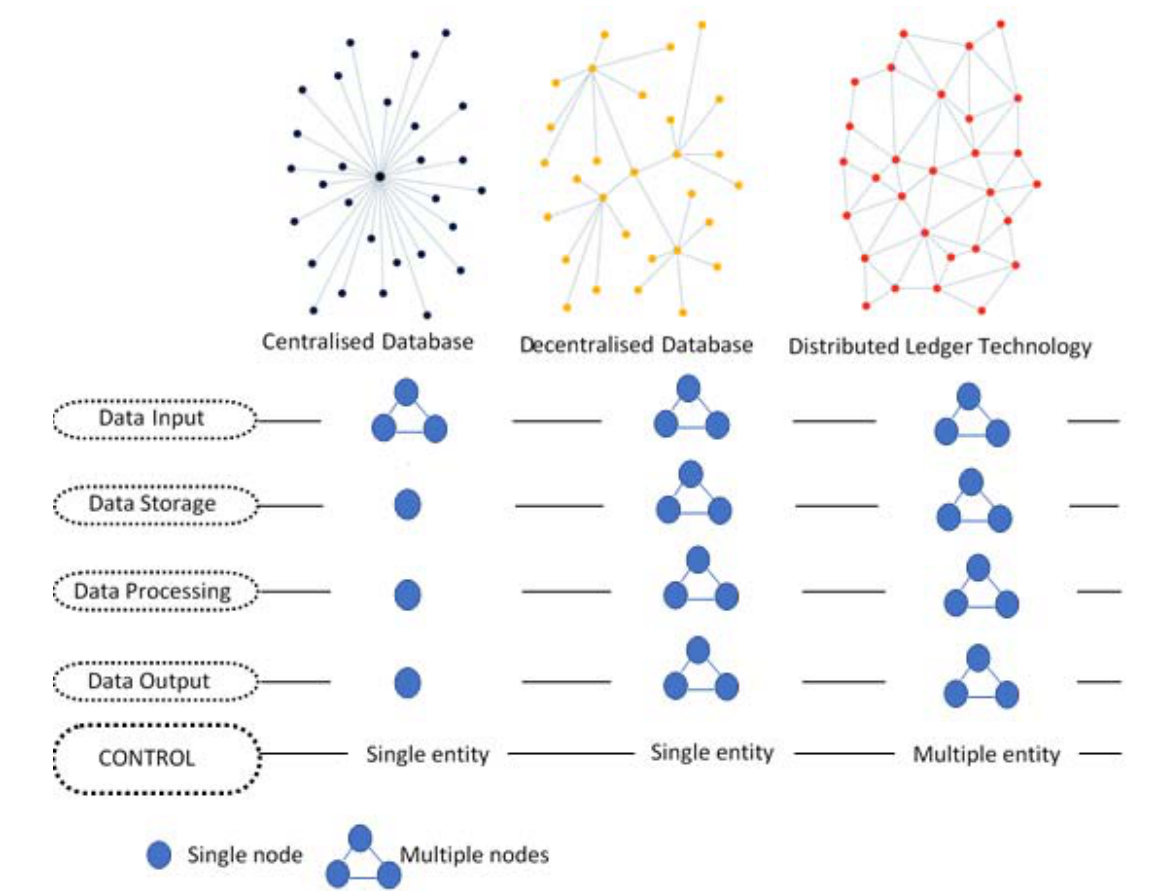
Figure 1. The differences between centralised databases, traditional decentralised databases, and distributed ledger technology (adapted from [2]).